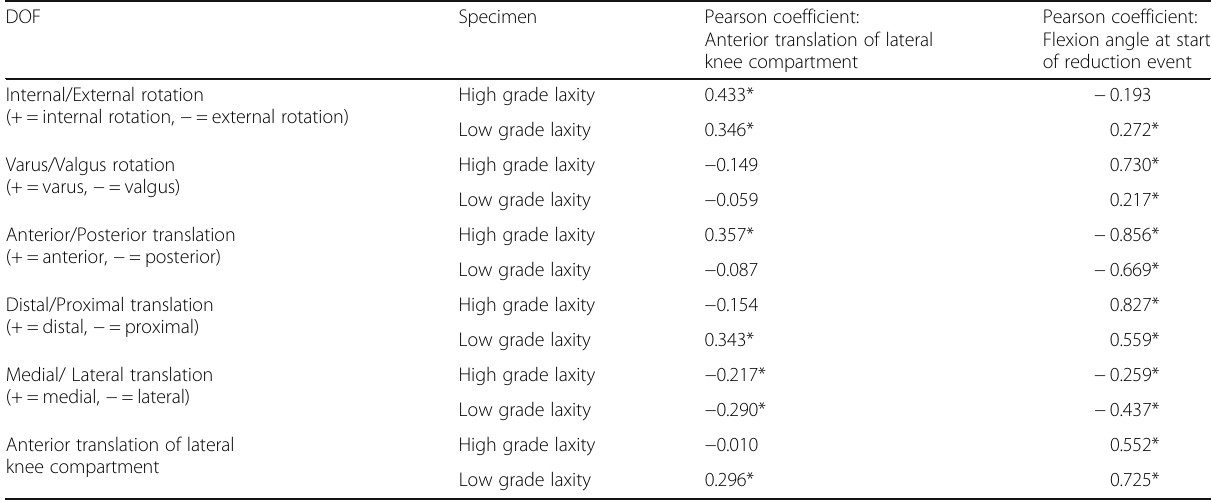
Table 2 Correlation of the knee position at the start of the reduction event of the pivot shift test with (A) the ensuing anterior translation of the lateral knee compartment and with (B) the flexion angle at the start of the reduction event in the high grade laxity specimen and low grade laxity specimen